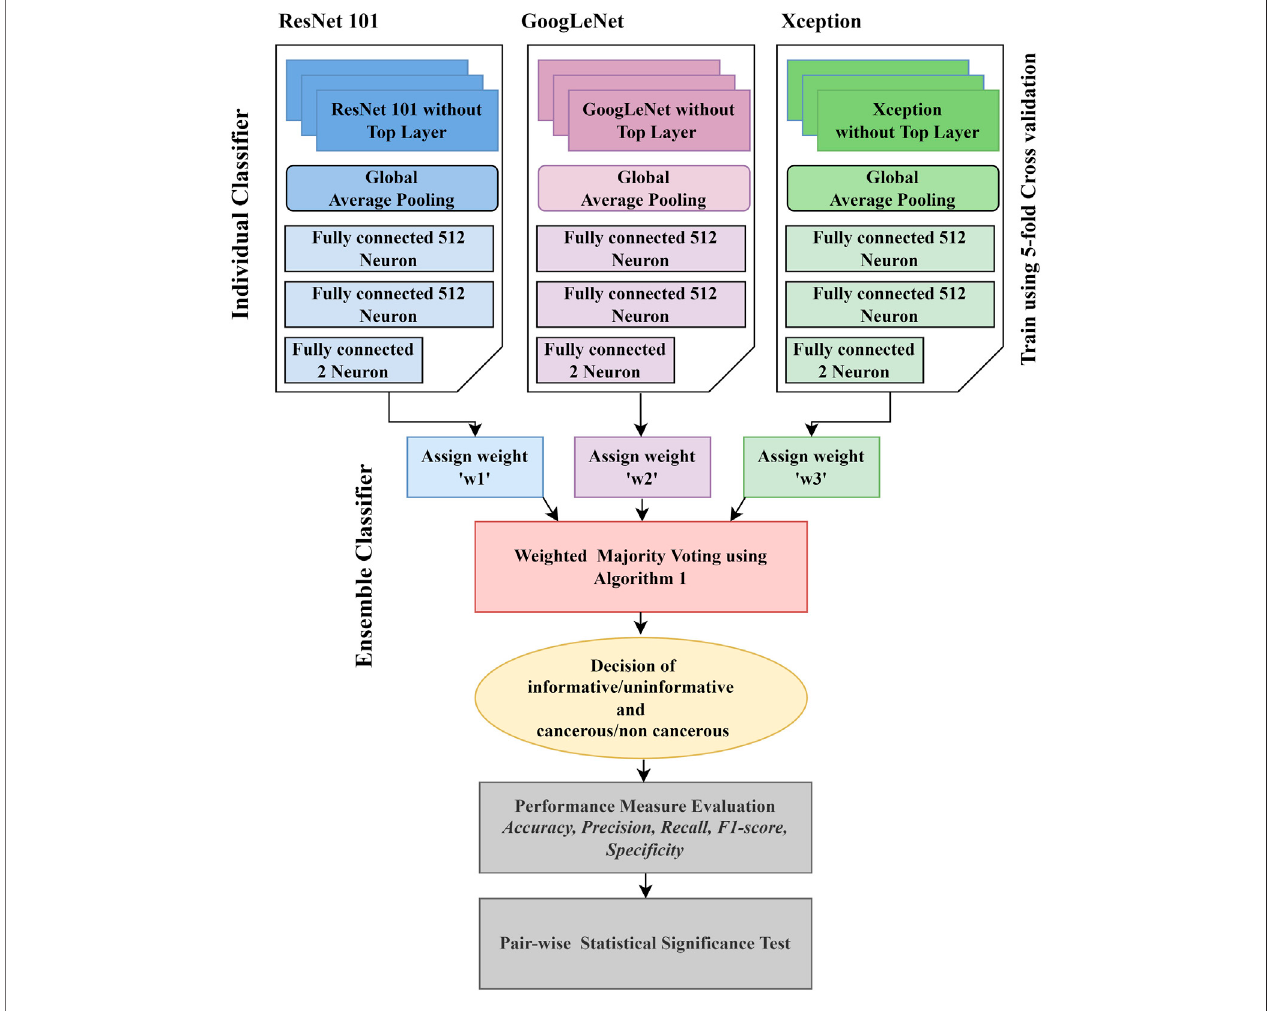
FIGURE 1 | Work fl ow of the proposed system.